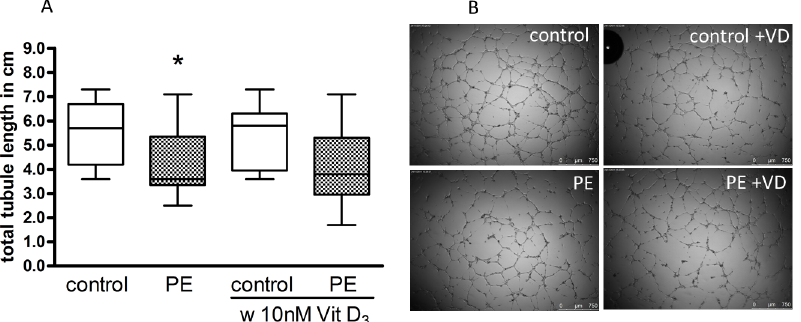
Fig 2. Building of tubule-like structuresby uncomplicated pregnancy (control) and preeclampsia (PE) HUVEC, and the effect of 1,25(OH) 2 vitamin D 3 , on capillary-tube formation by HUVEC in a Matrigel assay. (A) Capillary-tube formation (averagetotal tubule length per microscopic field) was analyzedafter 6 h by visual microscopy at 2.5 magnification. Data are expressedas total tubule lengthin cm. * P < 0.05 vs. control. The ends of the whiskers represent the maximum and minimum measuredvalues. Distributionwas examinedusing Kolmogorov-Smirnov test. Continuousdata were compared with Mann-Whitney test. (B) Representative photomicrographsof HUVEC after incubation in Matrigel. Scale bar represents 750 μ m.